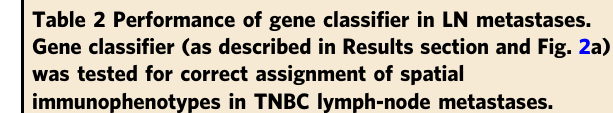
Table 2 Performance of gene classi fi er in LN metastases. Gene classi fi er (as described in Results section and Fig. 2a) was tested for correct assignment of spatial